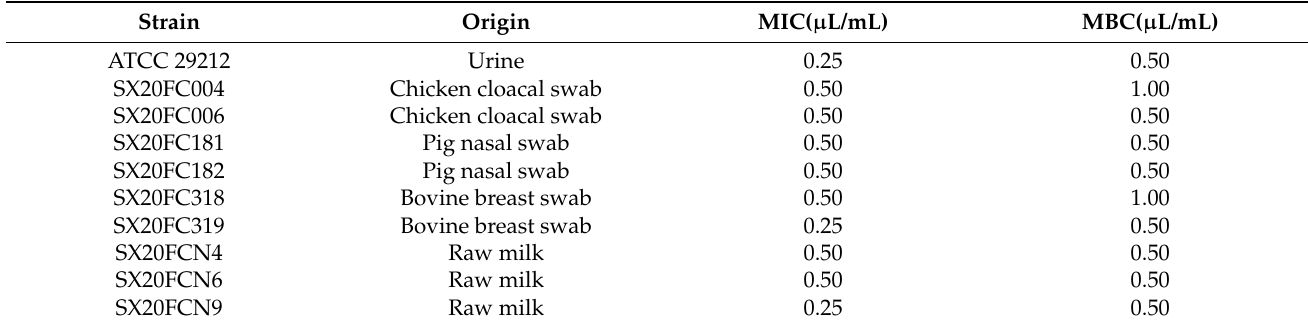
Table 1. The MICs and MBCs of OEO against E. faecalis